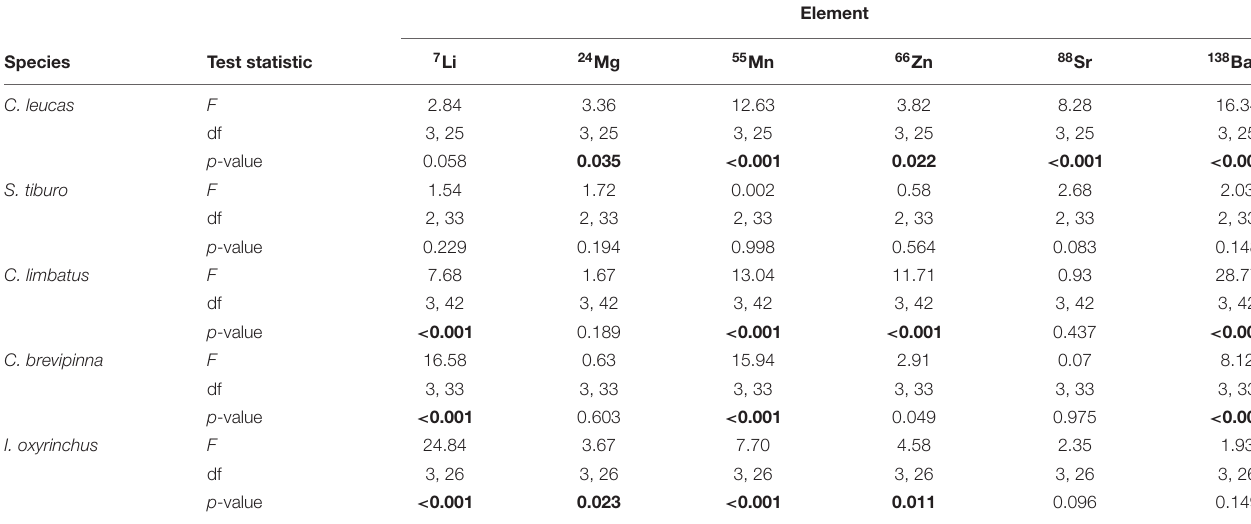
TABLE 3 | Results from ANOVA tests comparing mean elemental values among life stages for each species and element independently.